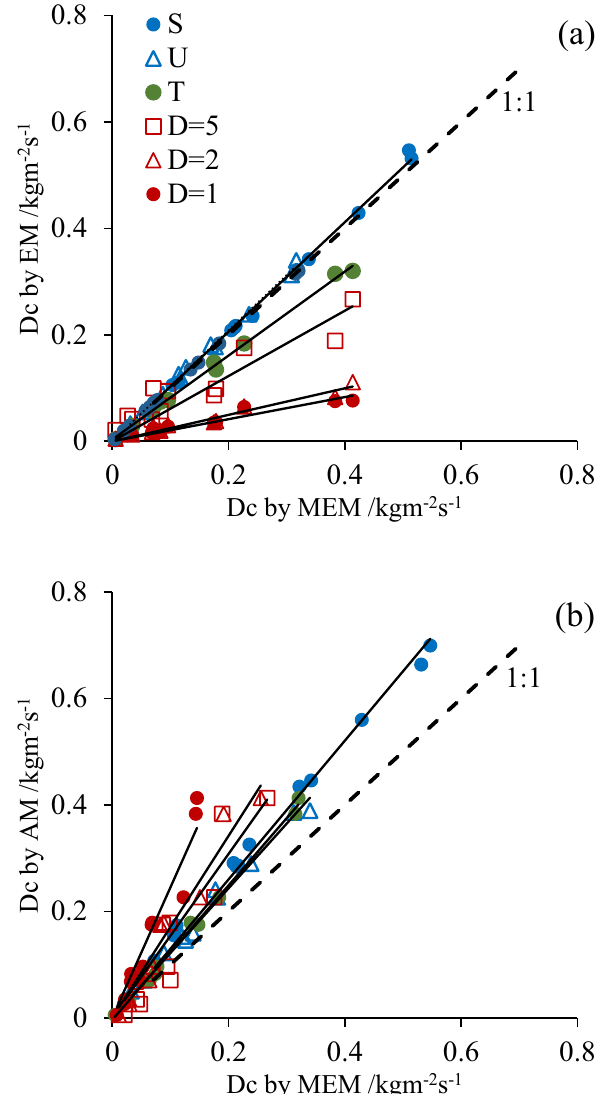
Figure 4. Comparison of Dc computed by AM, EM, and MEM from the experimental data in references. The legend in the figure is: S and U are saturated and unsaturated soil in 23 , T is thawed soil in 23 , D is thawed depth of frozen soil which is 1, 2, and 5 cm in 13